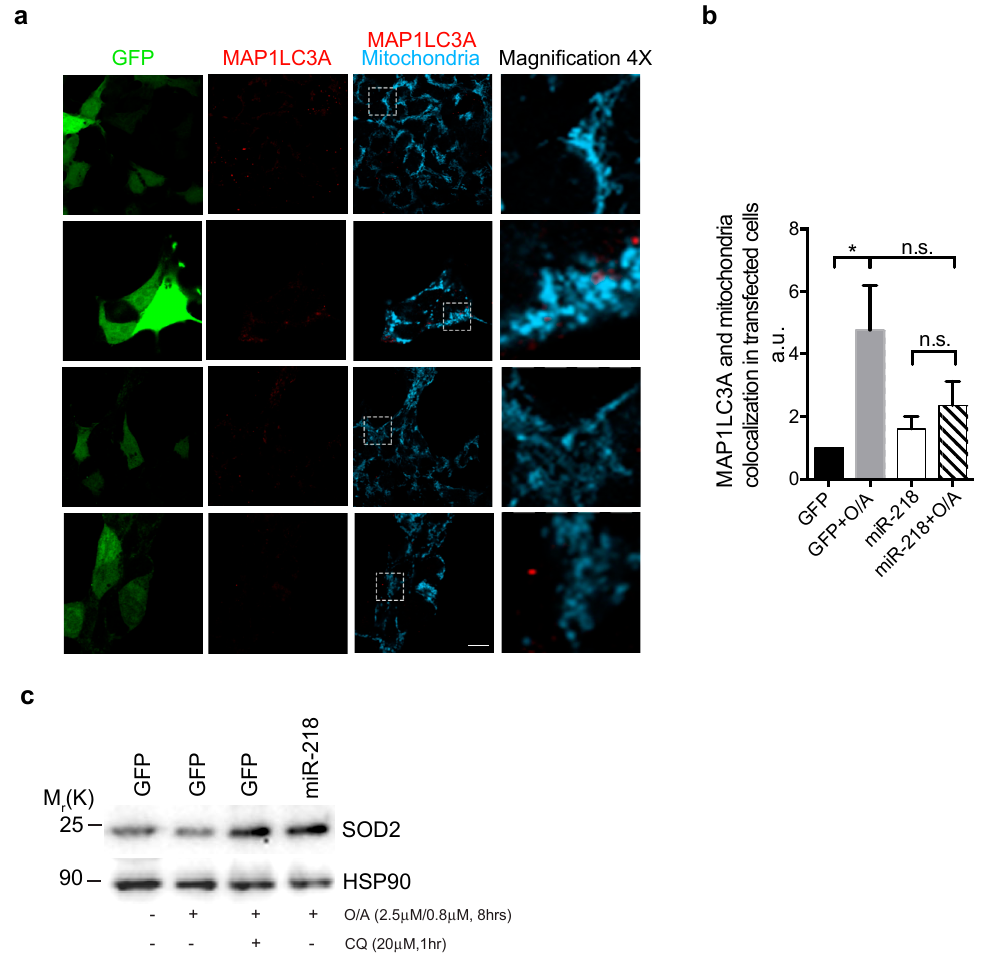
Figure 4. ( a , b ) Representative immunofluorescence image and related graph of HEK293 cells transfected with GFP or GFP-miR-218 vectors were treated with O / A for 5 h and immunostained with an anti-MAP1LC3A antibody (red) and an anti-TOMM20 (cyan) to detect mitochondria. Scale bar, 7 µ m. The right panels report the magnifications (4X) of the images that are in the white dotted frames. Data represent the mean of three di ff erent samples ( ± s.e.m.) and are representative of experimental triplicate. * p < 0.05, n.s. (not significant). Statistical analysis was performed using One-Way ANOVA with Sidak’s correction. ( c ) Representative image of HEK293 cells transfected as in ( a ) and treated with O / A for 8 h in combination or not with the autophagosome-lysosome fusion inhibitor chloroquine (CQ), were immunoblotted for the indicated antibodies.